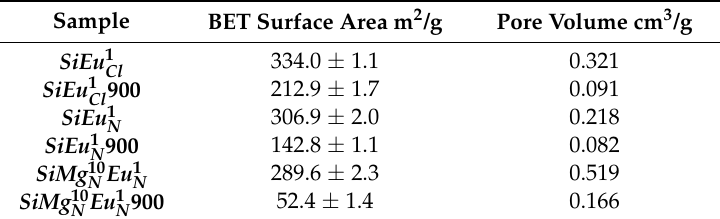
Table 1. BET surface area and pore volume for representative samples before and after annealing. Sample